Question: Sum up the contents of this chart in one sentence.
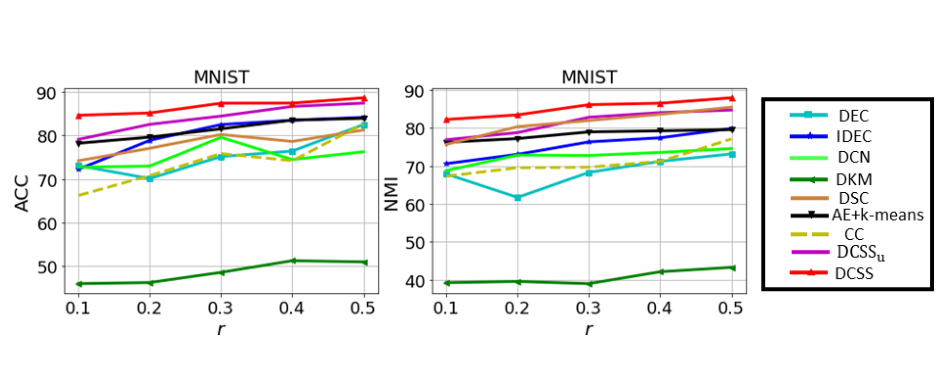
Answer: The clustering performance of different methods on imbalanced samples of MNIST.